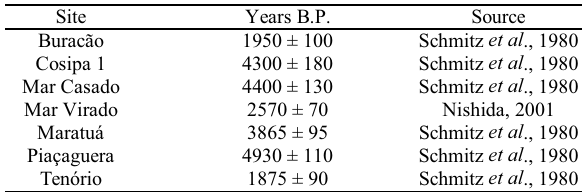
Table 1 . Radiocarbon dates for shell mounds on the Coast of São Paulo.